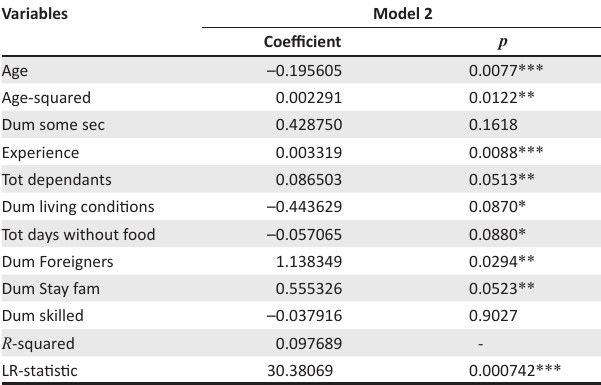
TABLE 7: Windhoek day labourers’ subjective well-being ordered-probit analysis 2